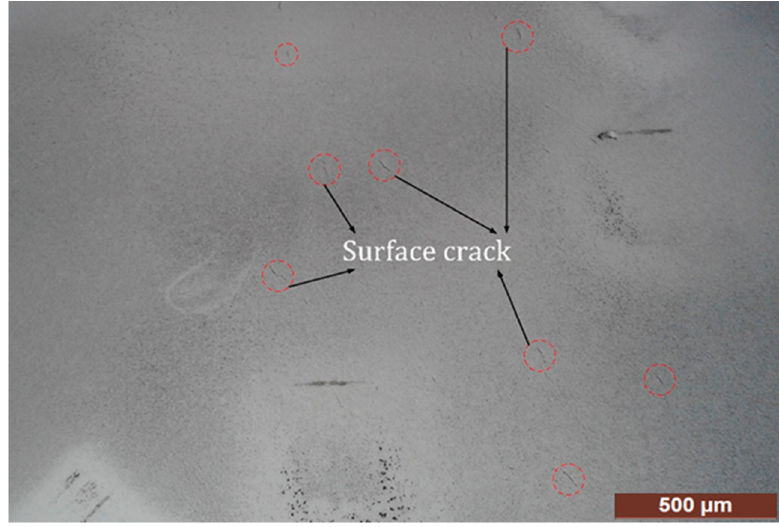
Figure 8. Surface cracks after performing magnetic particle testing.